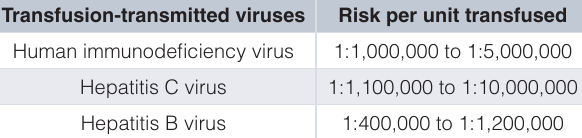
Table 1. Transfusion-transmitted viruses. Current testing of blood donors miss these viruses if the donors are in the “window period” when they are infected but do not yet test positive 1–4